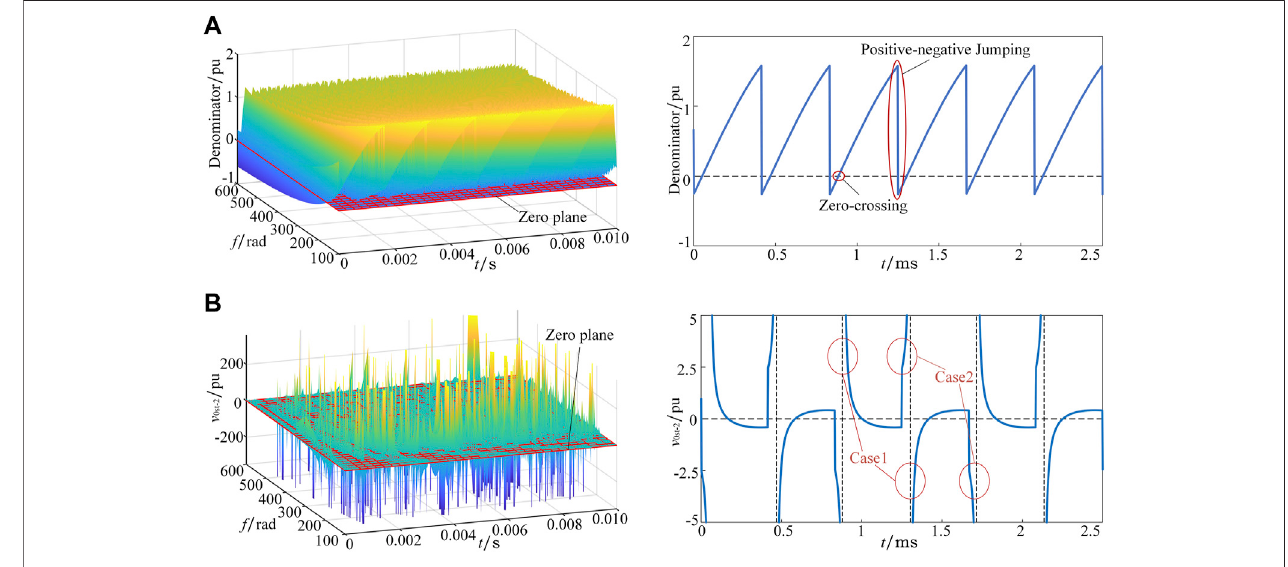
FIGURE 5 | Function surfaces and curves: (A) denominator, (B) v 0st-2 .